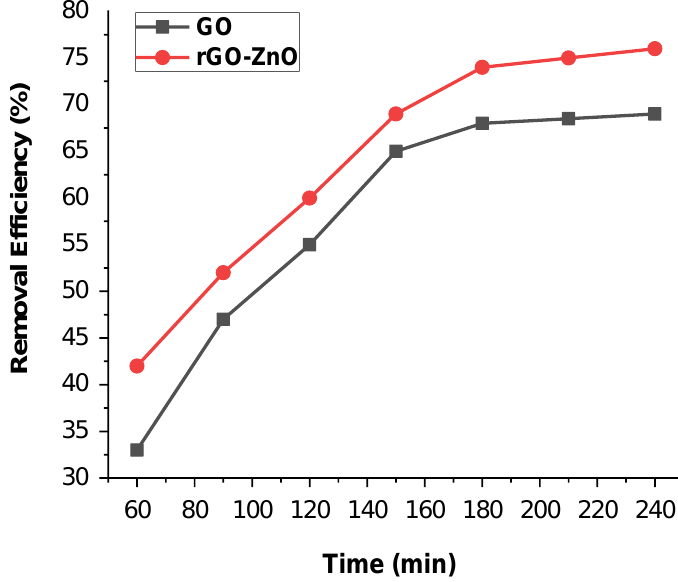
Figure 8. Contact time impact on the removal of Cr (VI) by GO and rGO-ZnO.